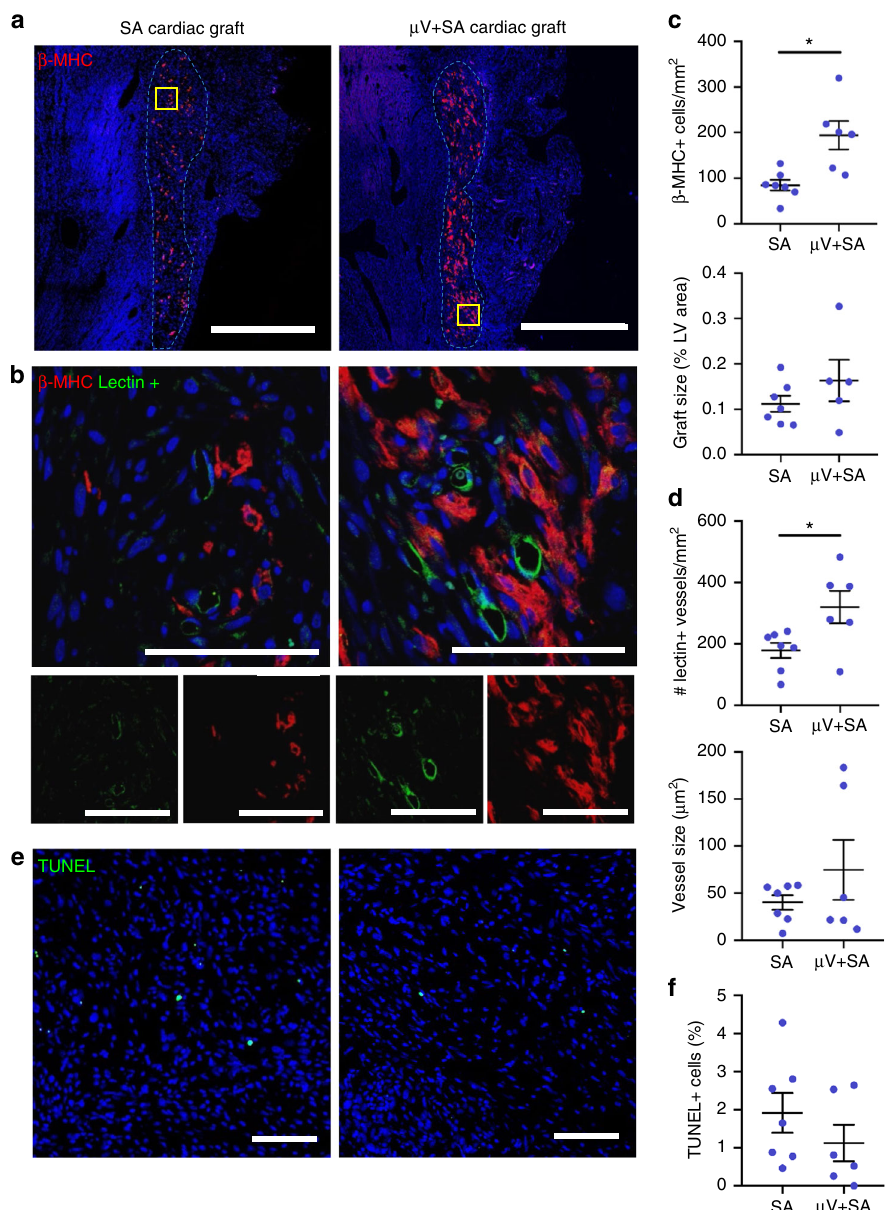
Fig. 7 Perfusable cardiac constructs in infarcted rat heart model 5 days post-implantation a , b Immuno fl uorescent-stained paraf fi n sections of self- assembled (SA; left) and µ V + SA (right) cardiac grafts: a Whole-graft section containing human embryonic stem cell-derived cardiomyocytes (hESC-CMs) ( β -MHC, red). Gray dotted line outlines graft tissue. Scale bar, 1 mm. b High magni fi cation images of boxed region in a (yellow box) with hESC-CMs ( β - MHC, red, bottom right) and perfused vessels (Lectin + , green, bottom left). Merged, top. Scale bar, 100 μ m. c Quanti fi cation of cardiomyocyte density (number of β -MHC + cells per mm 2 ) and β -MHC + graft size (% LV area). N = 7 and 6 biologically independent animals for SA and µ V + SA, with one animal with µ V + SA graft excluded from graft size calculation due to partial graft removal during tissue processing. p = 0.015 for density, p > 0.05 for graft size (two-tailed t test). d Quanti fi cation of vessel density (number of vessels per mm 2 ) and average vessel size for all perfused vessels (Lectin + ) in the cardiac grafts. N = 7 and 6 biologically independent animals for SA and µ V + SA, respectively. p = 0.046 for vessel density, p > 0.05 for vessel size (two- tailed t test). e Terminal deoxinucleotidyl transferase-mediated dUTP- fl uorescein nick end labeling (TUNEL) assay for apoptotic cells (TUNEL, green) on paraf fi n sections of SA (left) and µ V + SA (right) cardiac grafts. Scale bar, 100 μ m. f Quanti fi cation of apoptotic cells (TUNEL + ) as a percentage of all cells (human and host) in the graft. N = 7 and 6 biologically independent animals for SA and µ V + SA, respectively. p > 0.05 (two-tailed t test). Representative images for a , b , e from six biologically independent animals containing SA grafts and fi ve biologically independent animals containing μ V + SA grafts, with similar results. Hoechst-stained nuclei, blue. Data were collected from at least two confocal images of randomly selected regions per sample. Images analyzed by a custom lumen identifying code for vessel density and size. Error bars, mean ± SEM. * p < 0.05 determined using two-tailed t test. β